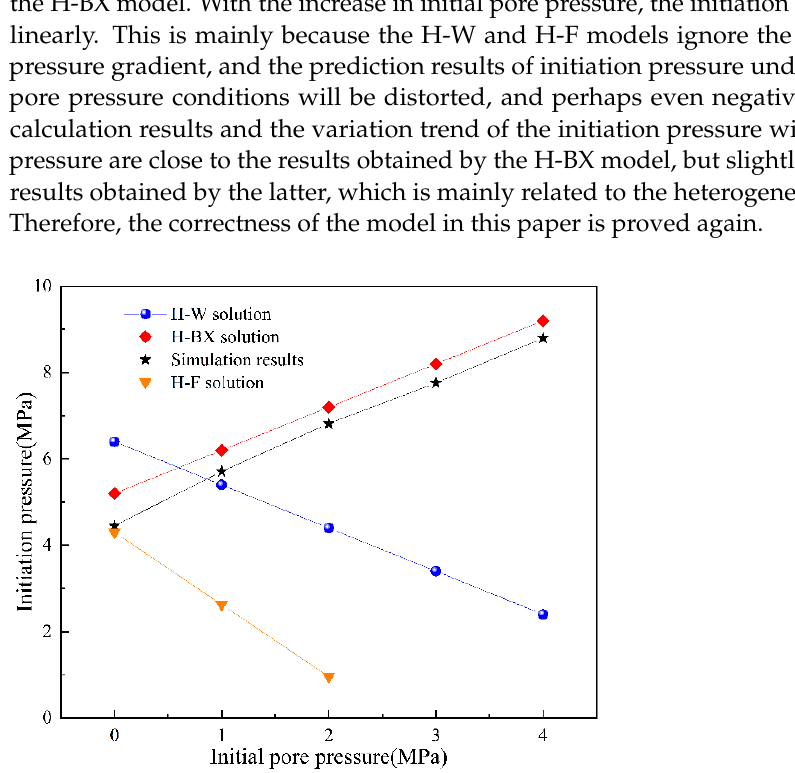
Figure 17. Change in crack initiation stress of fracturing holes with different initial pore pressures under various calculation methods.